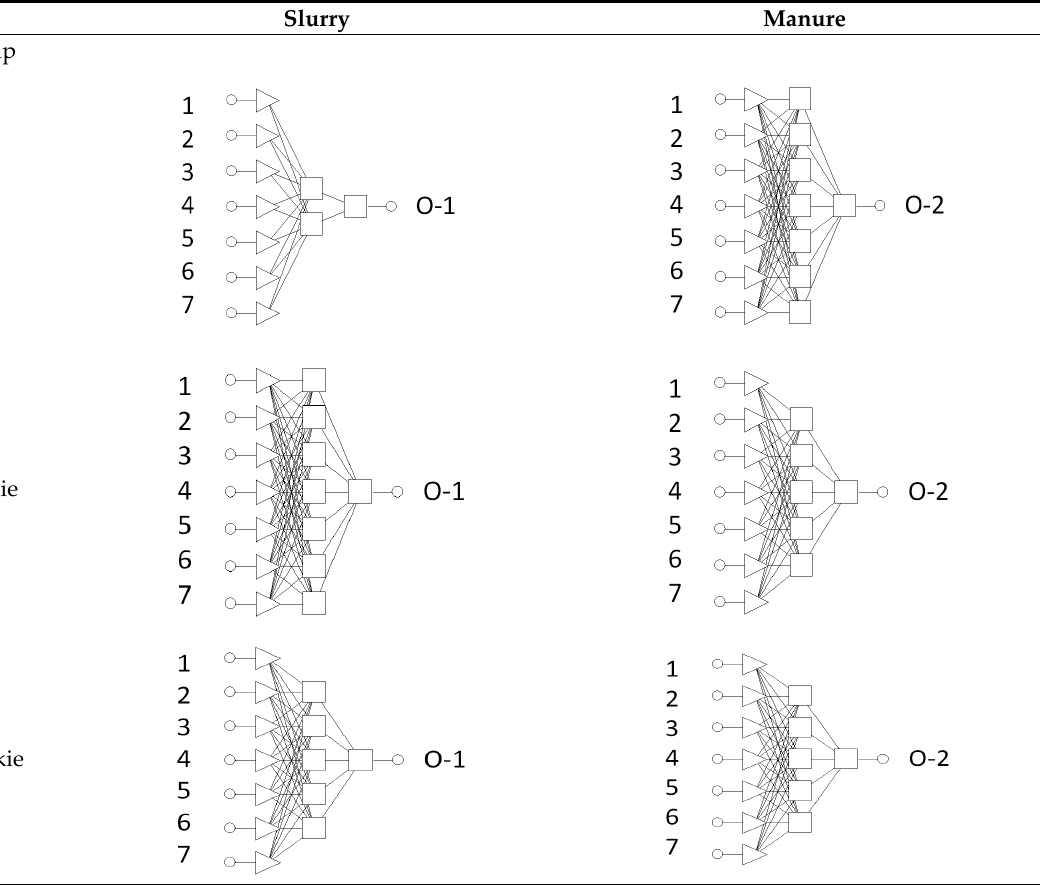
Figure 2. Structures of the generated MPL-type networks obtained for modeling the amounts of slurry or manure in the examined voivodeships, as indicated. Input and output variables are as described in Table 2. Table 4. Regression statistics of the obtained optimal neural models. S.D: ratio-quotient of standard deviations determined for errors and for data. Correlation standard: Pearson correlation coefficient between the results given by the generated neural model and the actual output values.